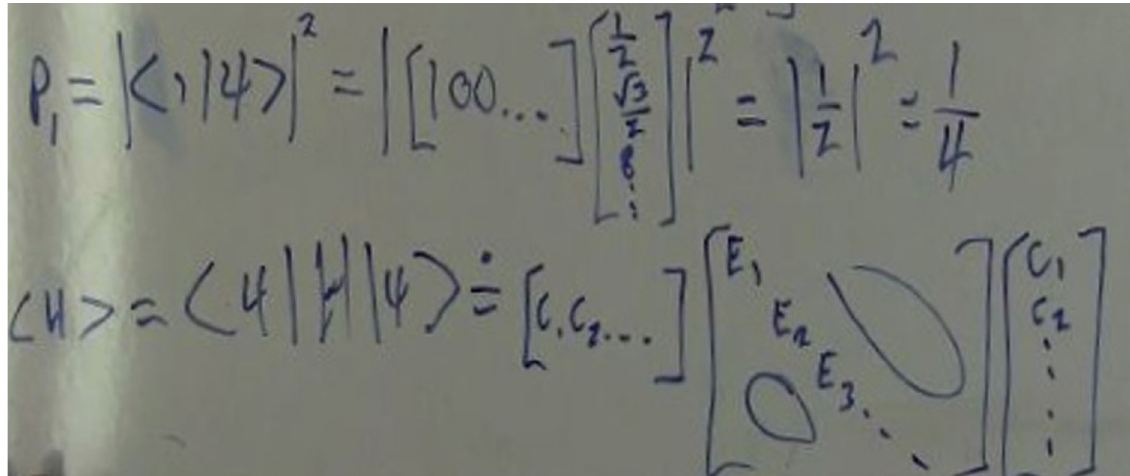
FIG. 3. Seth first uses Dirac notation as a template for an expression in matrix